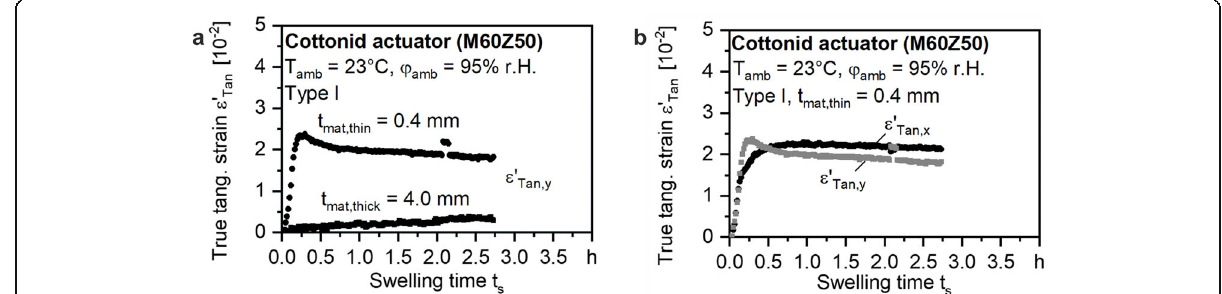
Fig. 9 Actuation tests on structurally optimized Cottonid variant M60Z50: a Influence of manufacturing direction, and b Influence of material thickness t